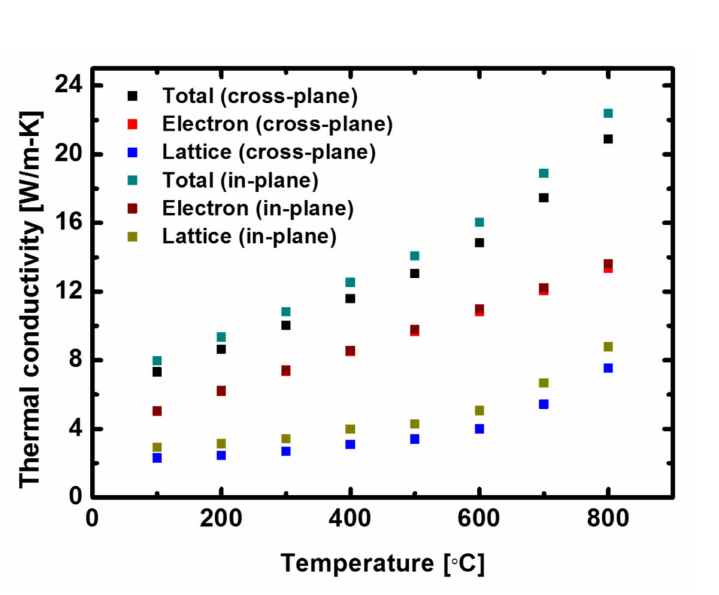
Figure 4. Dependence of cross-plane and in-plane electronic and lattice thermal conductivities on